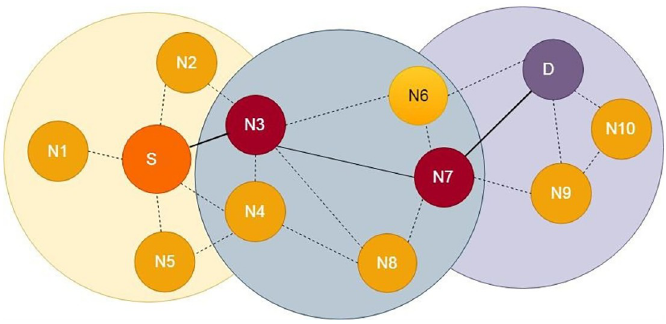
Fig 2. Appropriate forwarder node